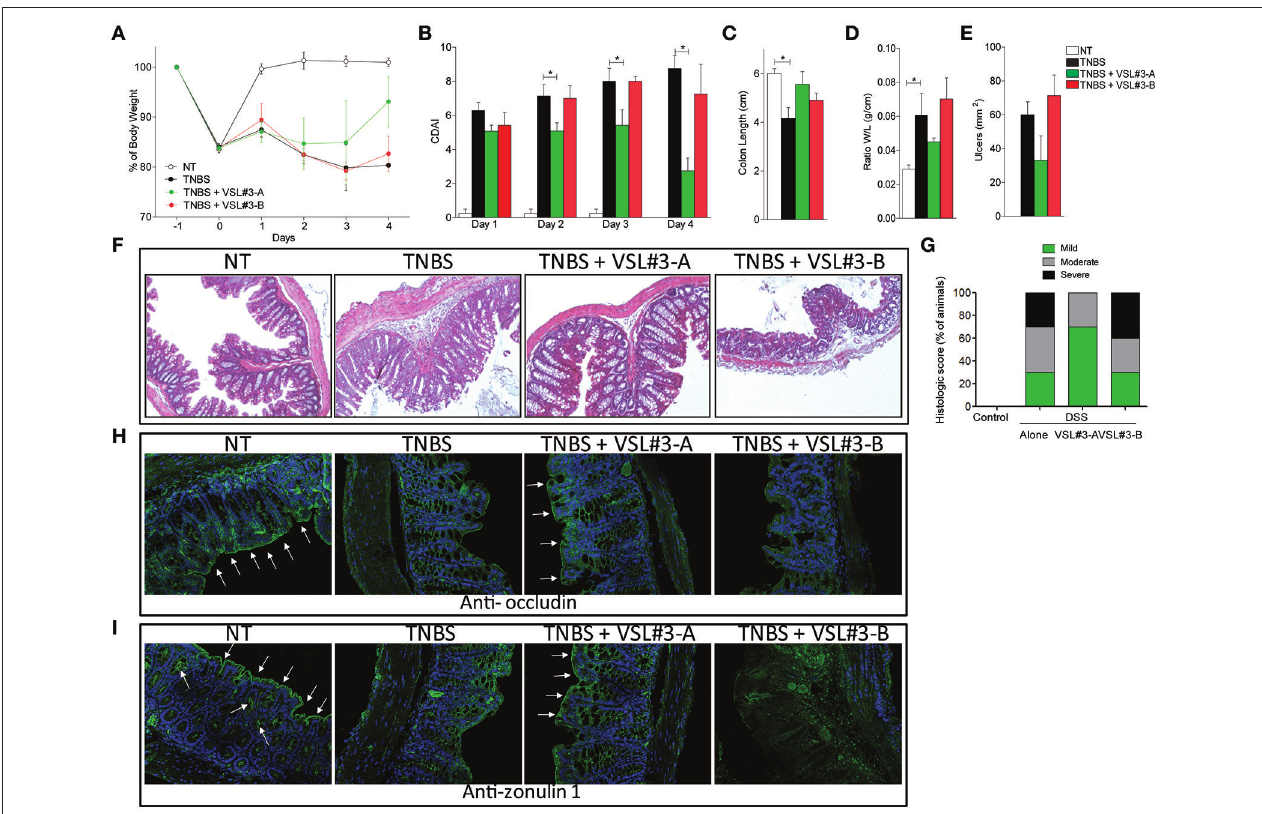
FIGURE 2 | Effects of VSL#3 on TNBS colitis. Mice were treated with TNBS and then administered with vehicle or one of the two formulations of VSL#3 by gavage from day 0 to day 4. VSL#3-A attenuated the development of wasting disease, i.e., change in body weight (A) and CDAI score (B) . (C–E) Only VSL#3-A reduced intestinal inflammatory score: colon length (C) , ratio between colon weight and colon length (D) , and ulcers area (E) . H&E staining on colon sections (F) and analysis of histological score (G) of control, TNBS treated, and TNBS plus one of the two formulations of VSL#3 (10x). Representative immunohistochemistry of colon with anti-occludin (H) and anti-zonulin1 (I) antibody for each experimental group. Results are the mean ± SEM of 4–7 mice per group (* P < 0.05).